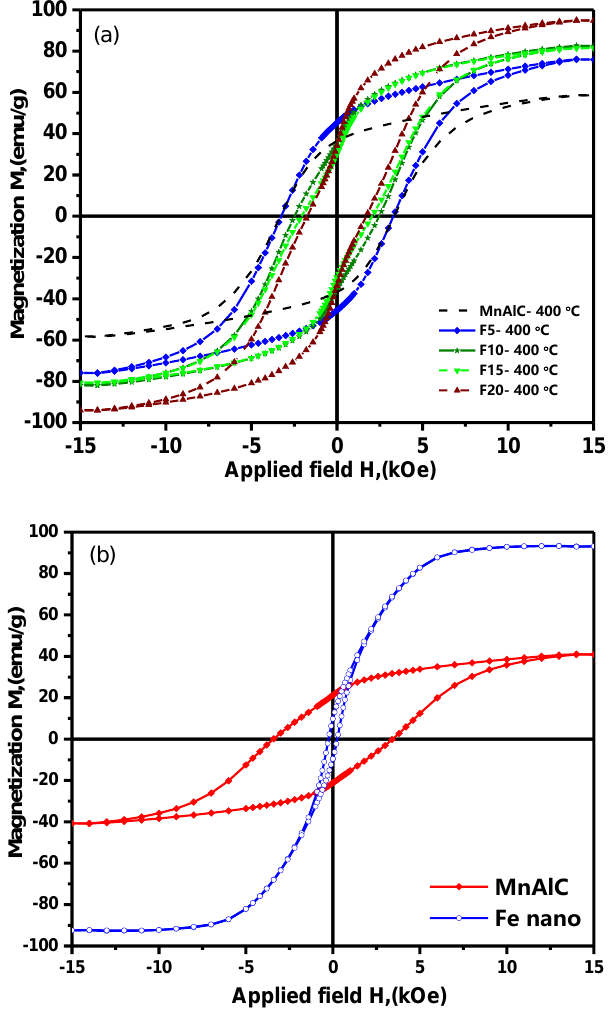
Figure 2. ( a ) Hysteresis loops of Mn-Al-C alloy, Mn-Al-C- α -Fe nanocomposite alloys with different amounts of α -Fe annealed at 400 °C for 30 min; ( b ) hysteresis loops of α -Fe and Mn-Al-C alloy without annealing.